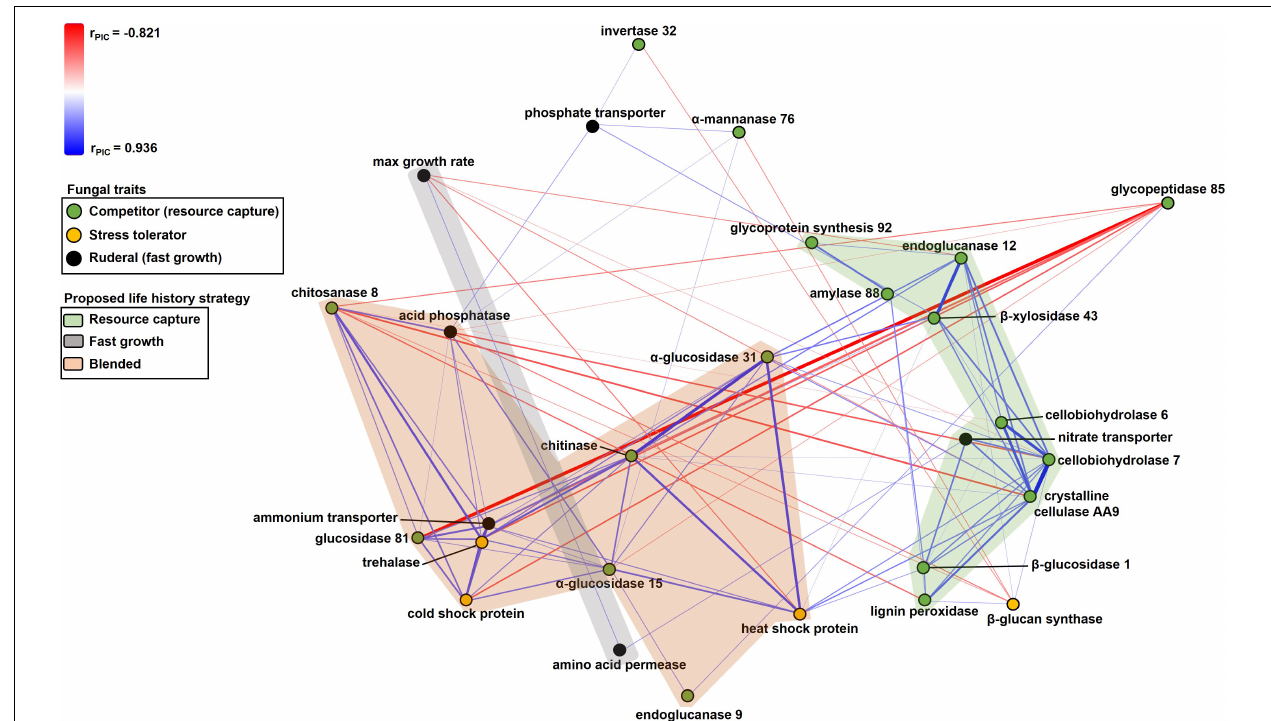
FIGURE 2 | Non-metric multidimensional scaling scatterplot of fungal trait relationships calculated using PIC r coefficients between traits ( n = 37). Symbols are traits; traits closer together tended to be more positively related to one another. Positive and negative relationships between traits are denoted by blue or red lines, respectively, with color intensity and thickness of lines proportional to the size of the PIC r coefficient. Trait symbols are colored according to their predicted life history strategies listed in Table 1 . Lines corresponding to PIC r coefficients in the range of –0.35 to 0.35 have been excluded for